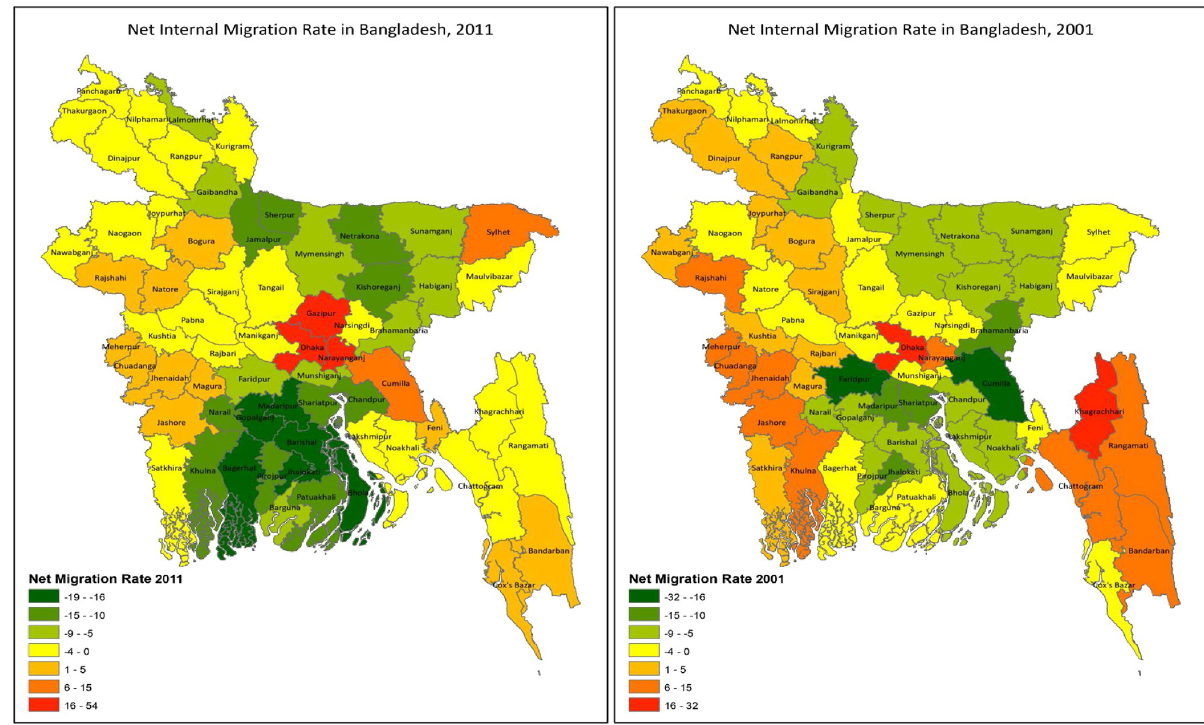
Fig 3. Net internal migration rate (%) in Bangladesh, 1991 to 2001 and 2001 to 2011. The maps were produced using ArcGIS (produced by authors). The maps presented the district-wise net migration rate based on indirect methods. The legends show negative migration to positive migration.